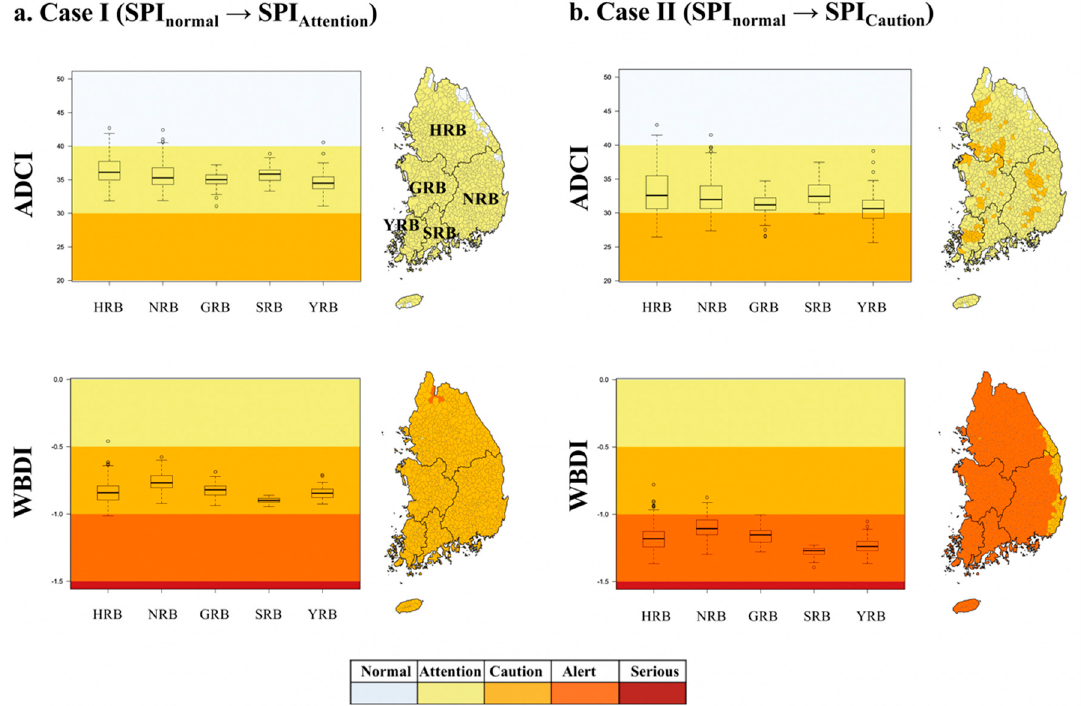
Figure 9. Drought condition changes in intentionally biased bootstrap (IBB) simulation. ( a ) Case I (SPI normal → SPI Attention ) and ( b ) Case II (SPI normal → SPI Caution ). The simulation results for the five basin areas are provided in the boxplot, and the results for the change in drought conditions are indicated in color in the map.